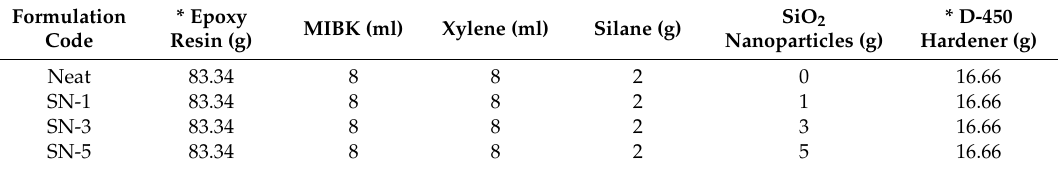
Table 1. Incorporation of nanoparticles (SiO 2 ) in epoxy / 2pack